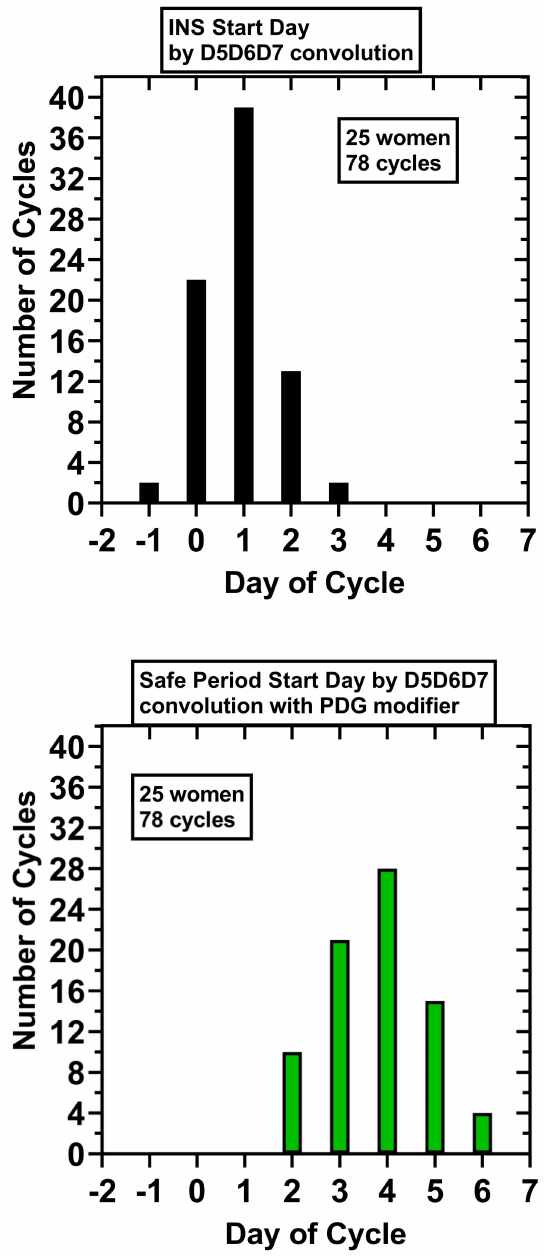
Figure 1. Start days of the indicator negative sequence (INS) by D5D6D7 convolution analysis